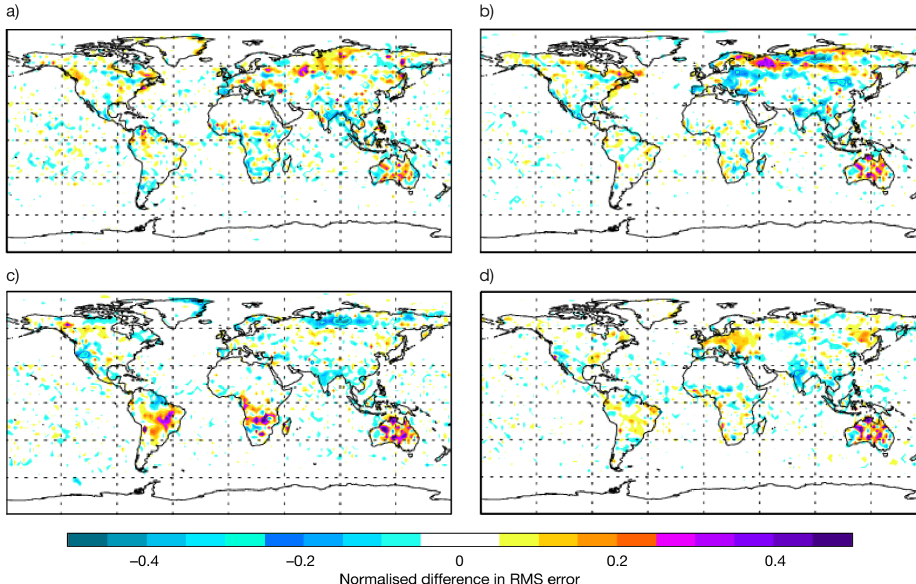
Figure 11. A 2 m temperature normalised RMSE difference between 36-h forecasts using ESA-CCI LU/LC with the new LAI disaggregation operator (CLAI) and a control simulation using the operational configuration (CTR) for JF ( a ), MAM ( b ), JJA ( c ) and SON ( d